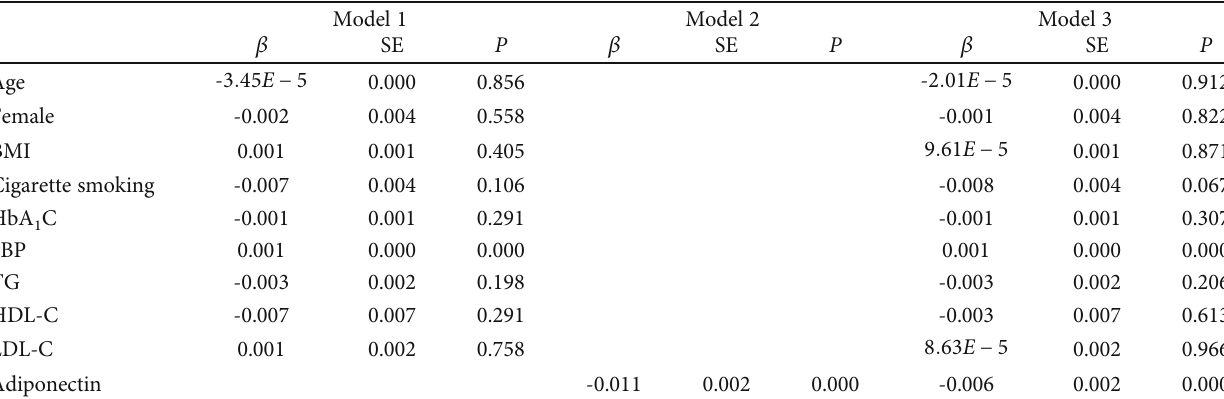
Table 6: Multiple linear regression analysis of relevant risk factors for